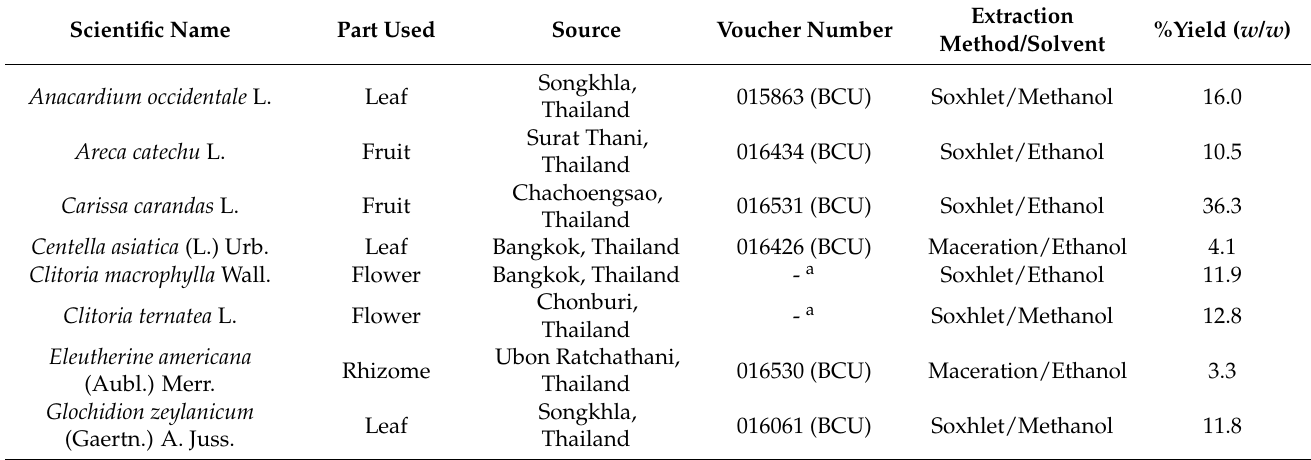
Table 1. Scientific name, parts used, source, and percent yield of Thai